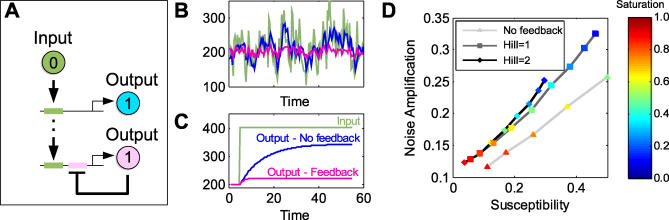
Comparison of a System with Negative Feedback and without Negative Feedback(A) A system with negative feedback (pink) and without negative feedback (blue) were compared in terms of (B) the output noise in response to fluctuations in the input (green), and (C) the deterministic response of the two systems to a 2-fold change in the input.(D) Noise amplification versus susceptibility for negative feedback with different Hill coefficients. The color-code is the level of saturation of the input promoter. Sensitivity was calculated by solving the steady-state equations after a 1% change in the input levels, and noise amplification was the result of stochastic simulations (Methods).